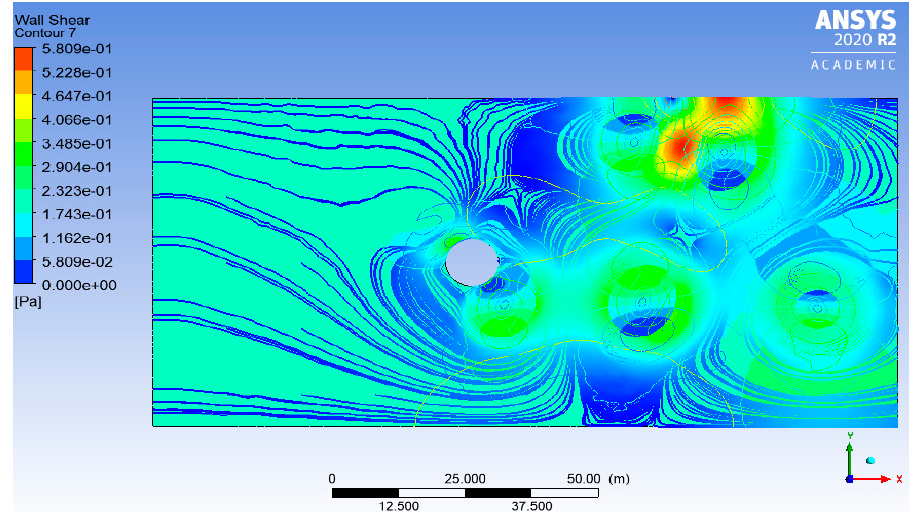
Figure 17. Pressure contour for the flow on the free-floating buoy under 1.5 m/s case.